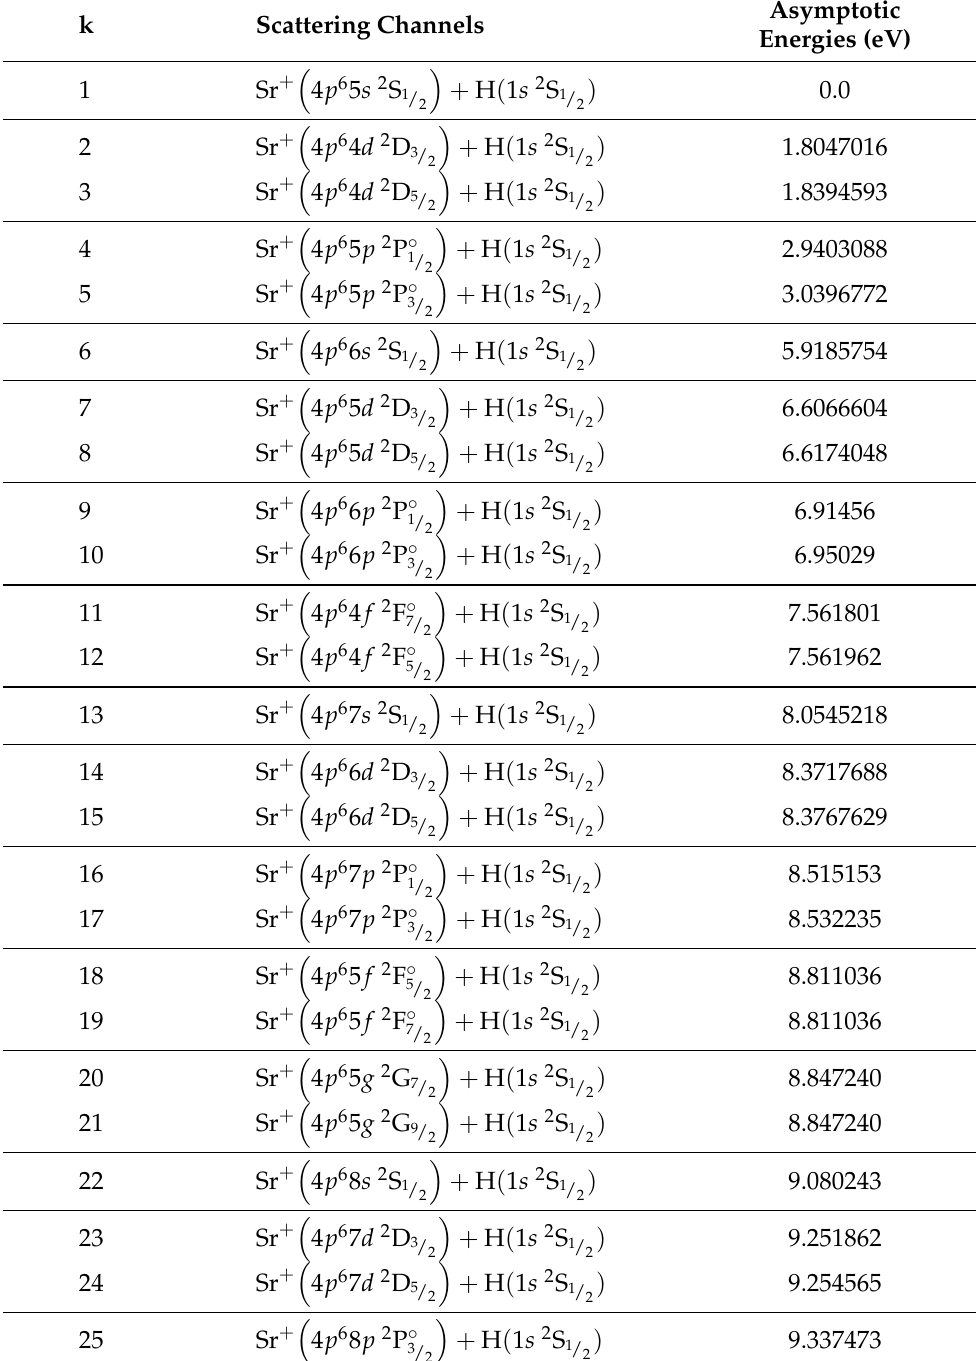
Table A1. SrH + (k 0 + ) molecular states (in the J-J representation), the corresponding scattering channels, their asymptotic energies with respect to the ground-state level (taken from NIST [31]). k Scattering Channels